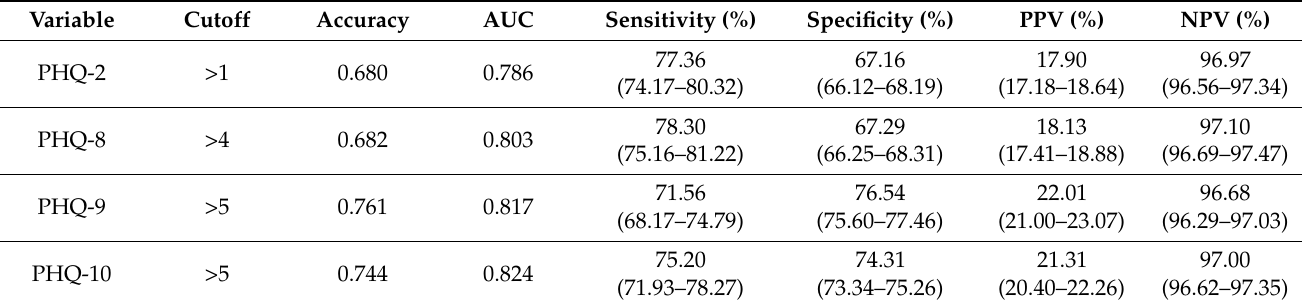
Table 2. Diagnostic characteristics of suicidal ideation assessment using PHQ cutoff